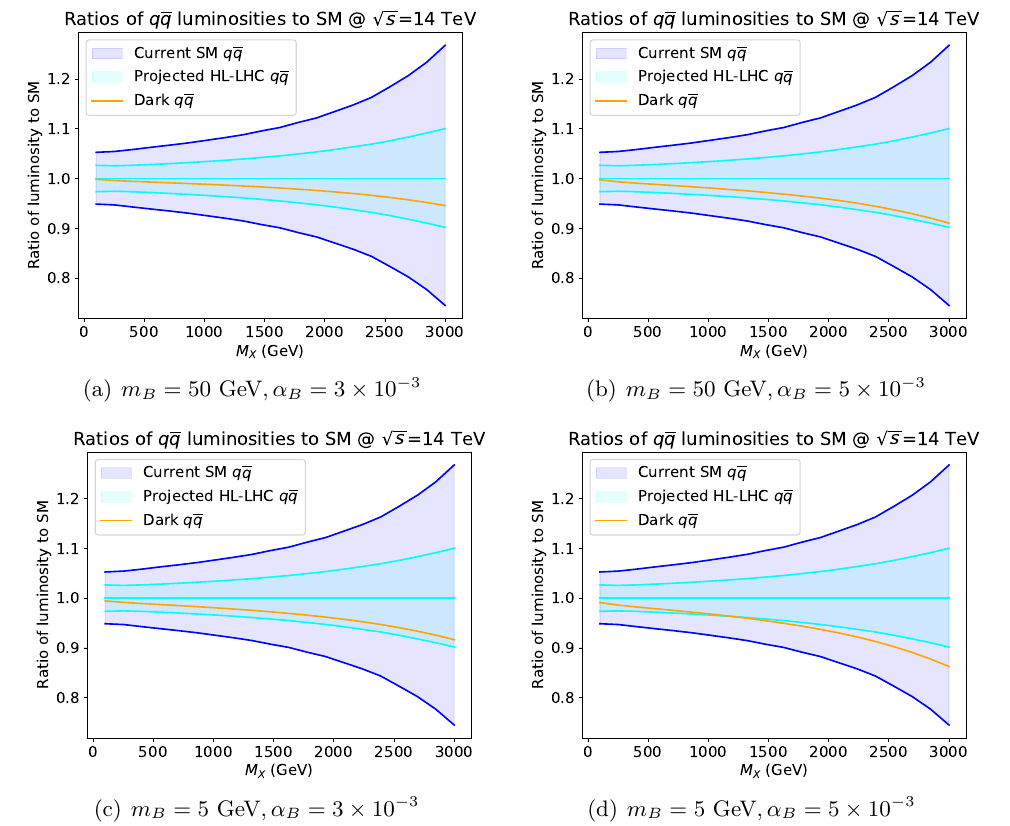
for the total quark-anti-quark luminosity, at the centre of mass Figure 5 . The ratio Φ Dark / Φ SM √ q ¯ q q ¯ q energy S = 14 TeV for the values of mass and coupling indicated under each panel. In each panel, the dark blue bands correspond to the current PDF uncertainty, while the light blue bands show the expected uncertainty on the PDF luminosity at the HL-LHC. See main text for more details.